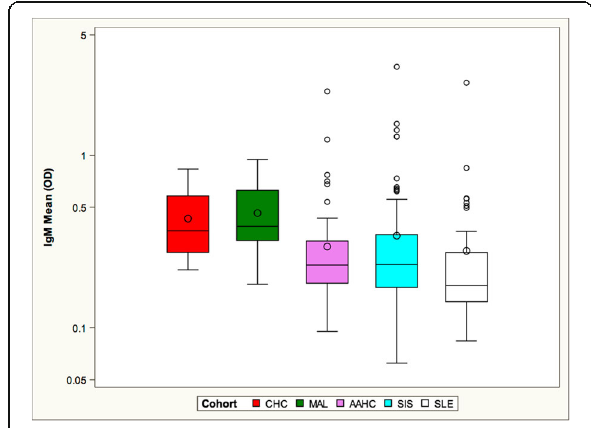
Fig. 1 The cohorts are organized in order of the presumed risk from lowest (left) to highest (right). The MAL cohort had the highest mean IgM anti-DNA level, followed by the CHC cohort. The mean of the SIS cohort did not differ from the mean of the AAHC and the SLE